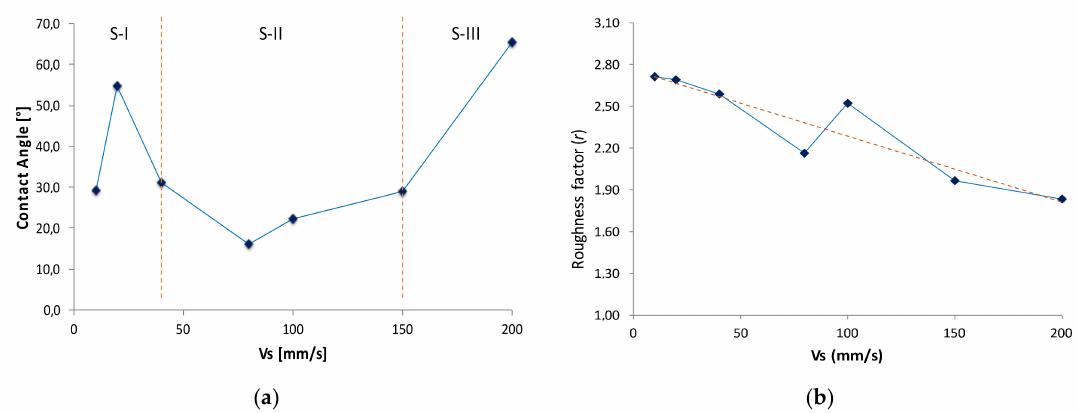
Figure 8. Wetting behavior as a function of the scanning speed of the beam’s ( a ) contact angle and ( b ) roughness